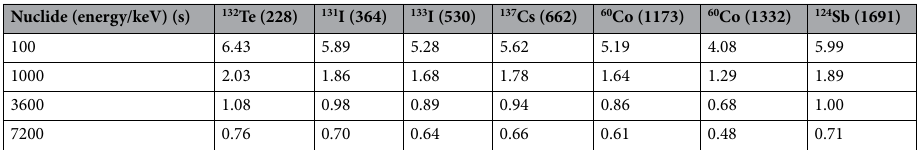
Table 7. Minimum detectable surface activity of the detection model (unit: Bq/m 2 ).